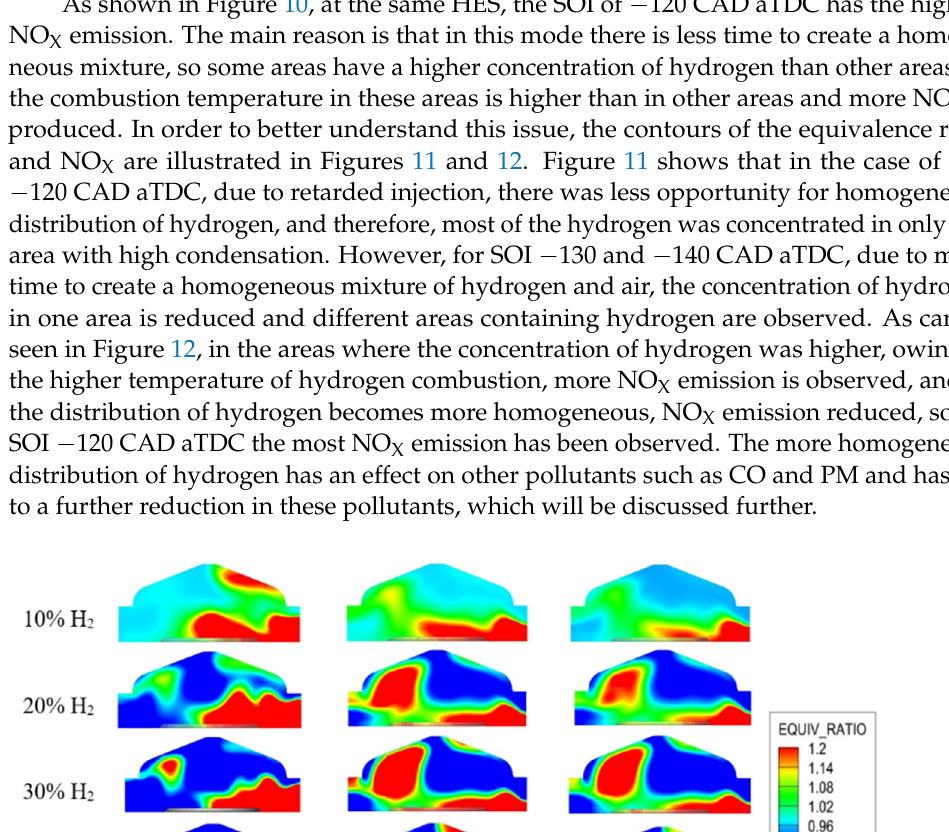
Figure 10. Influences of hydrogen direct-injection timing and HES on NO X emissions.